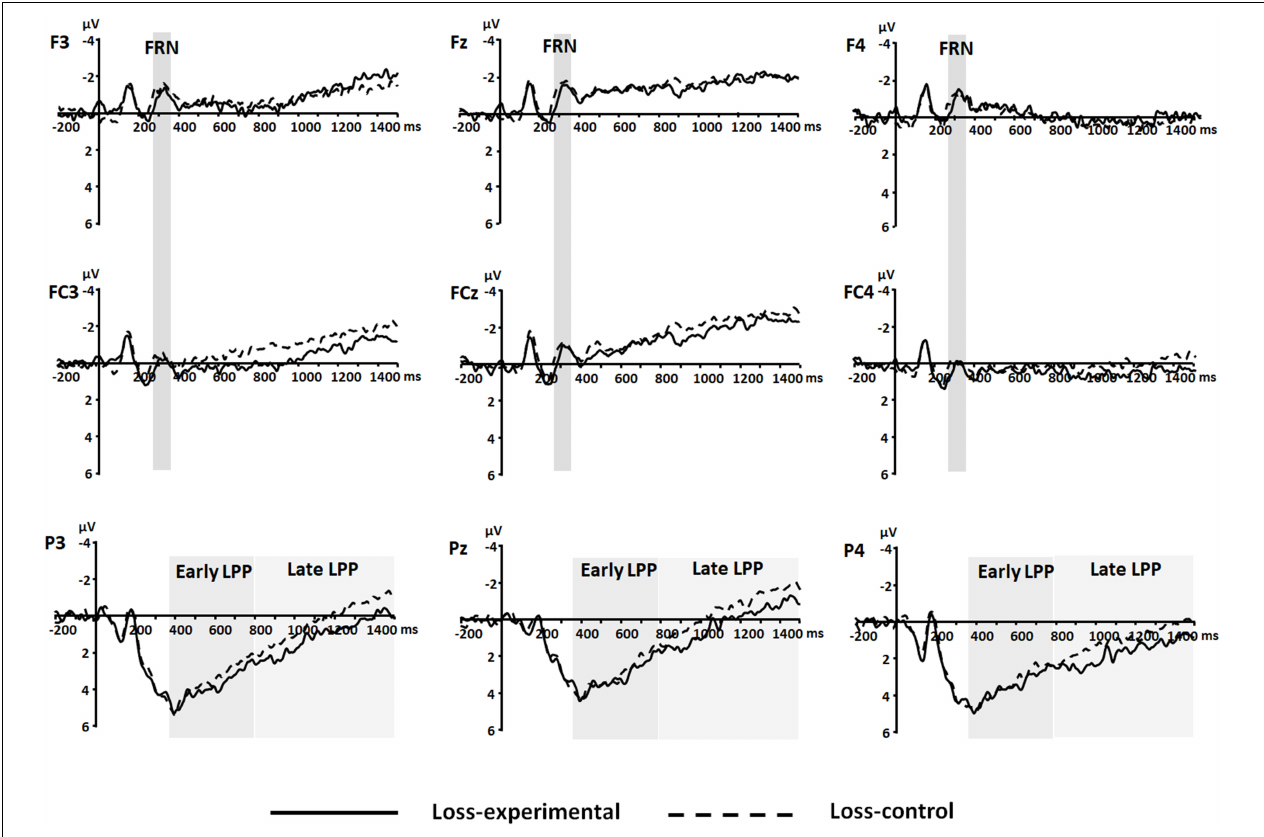
FIGURE 4 | Event-related potential (ERP) waveforms at frontal (i.e., F3, Fz, and F4), frontocentral (i.e., FC3, FCz, and FC4), and parietal (i.e., P3, Pz, and P4) electrodes for the experimental and control conditions in the loss frame. Shaded areas represent time windows for feedback-related negativity (FRN) (264–364 ms) and early and late positive potential (LPP) (364–800 ms and 800–1,500 ms, respectively). The presented waveforms were obtained by averaging the waveforms across trials ( means of trial numbers were 41.46 and 42.22 in the experimental and control conditions, respectively) and of 32 participants within the respective